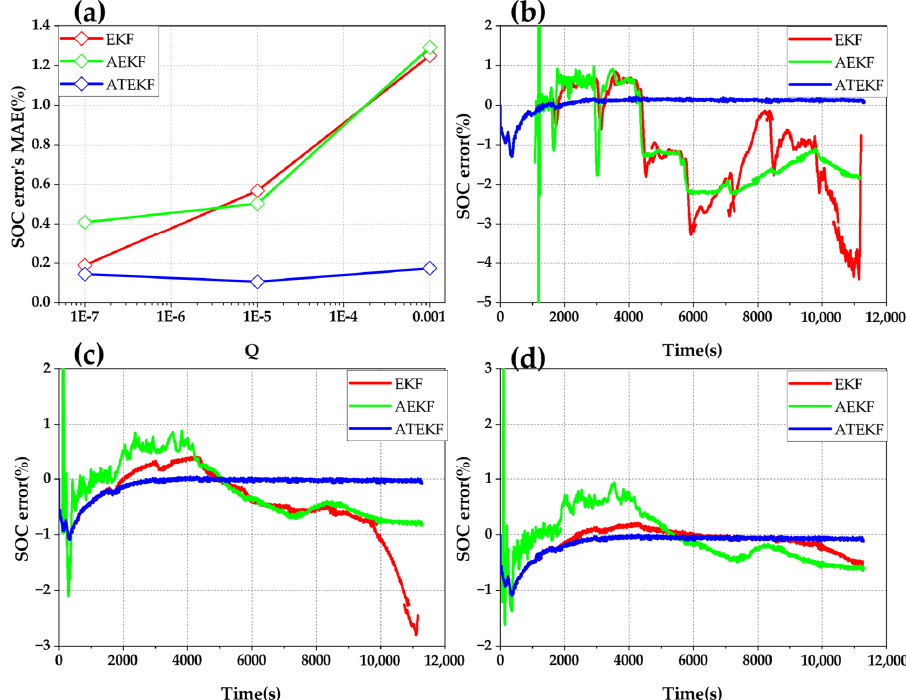
Figure 13. SOC error of three algorithms under different process noises: ( a ) MAEs of EKF, AEKF, and ATEKF under different process noises; ( b ) SOC error comparison of EKF, AEKF, and ATEKF with Q = 10 - 3 × eye ( 2 ) ; ( c ) SOC error comparison of EKF, AEKF, and ATEKF with Q = 10 - 5 × eye ( 2 ) ; ( d ) SOC error comparison of EKF, AEKF, and ATEKF with Q = 10 - 7 × eye ( 2 ) .